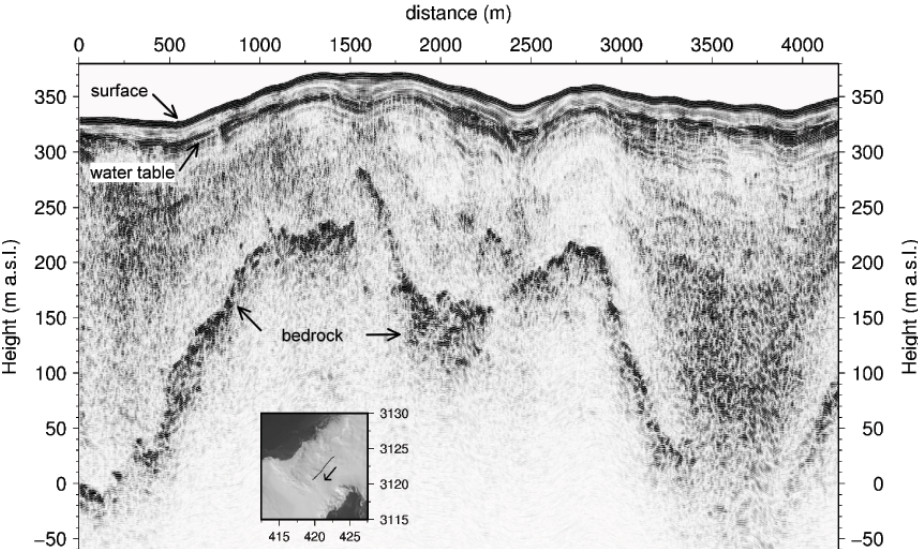
Figure 3. Typical example of an airborne radargram. The inset shows the profile location and flight direction. Surface, water table (depth between 20m and 30m) and bedrock reflections are